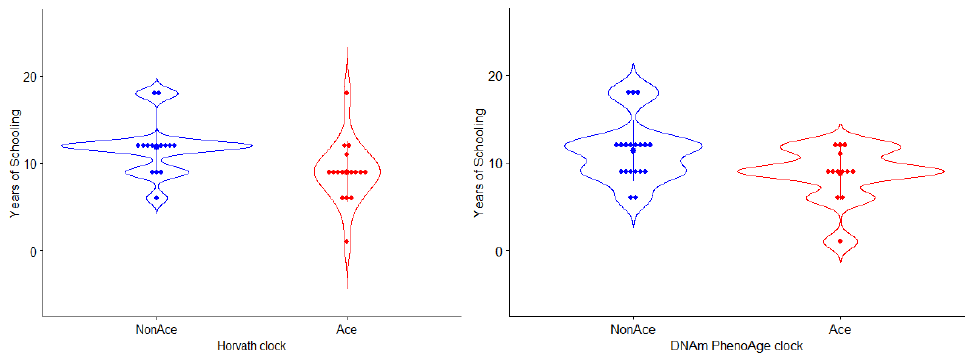
Figure 2. Differences between individuals with epigenetic age acceleration and years of schooling. Note: Blue colors represent individuals with no acceleration on epigenetic clocks, and red represents individuals with accelerated epigenetic aging.